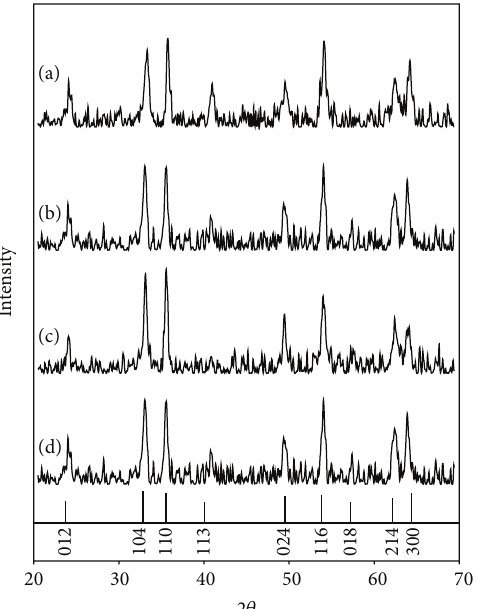
Figure 1: X-ray diffraction patterns of the prepared catalysts after calcinations ((a) HLB = 13.9, (b) HLB = 23.7, (c) HLB = 31.2, and (d) HLB = 40).